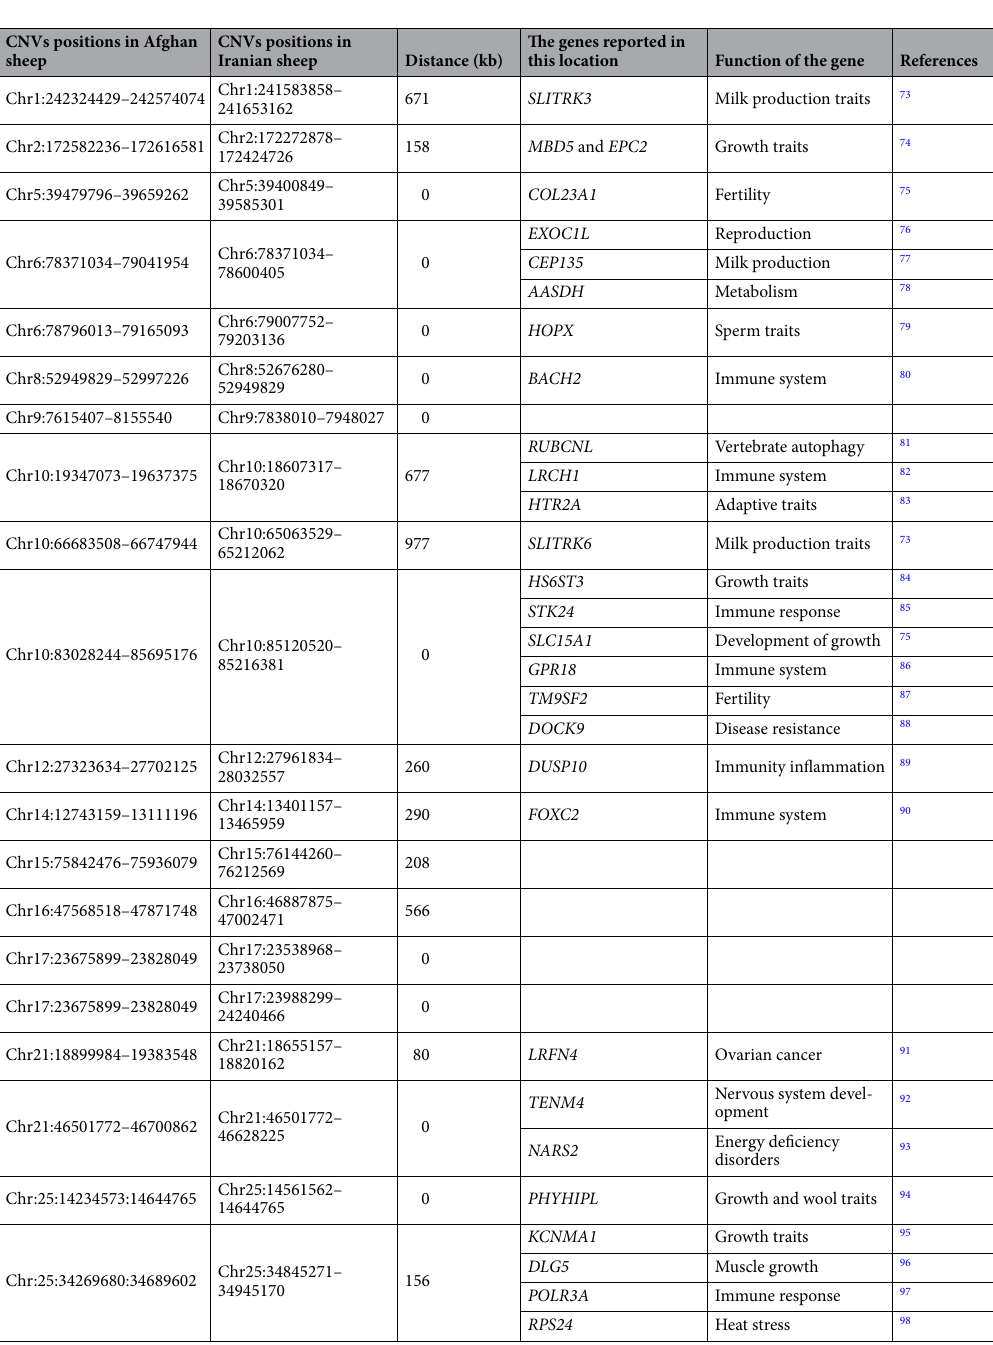
Table 4. The list of CNVs overlapped between Afghan and Iranian sheep breeds and the genes and their functions reported in these